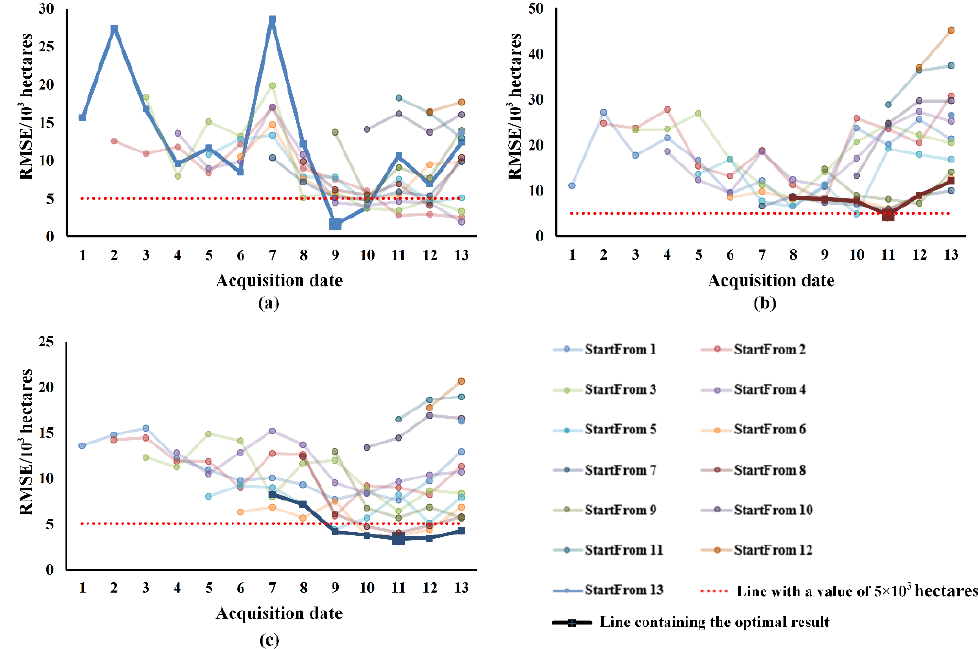
Figure 8. Based on different multi-temporal datasets, RMSE of pseudo-labels in the different parts of the target region directly extracted by the well-trained transfer model; ( a – c ) are RMSE values of pseudo-label in the northern, central, and southern target region, respectively. Each point reflects the classification results of the transfer model using temporal input to the corresponding time steps.